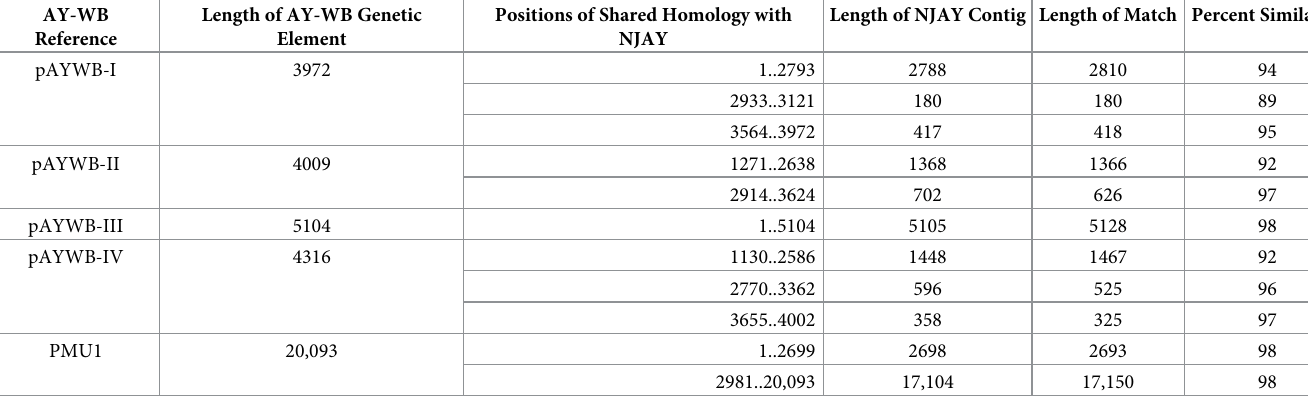
Table 2. Sub-assembled extrachromosomal NJAY sequences.